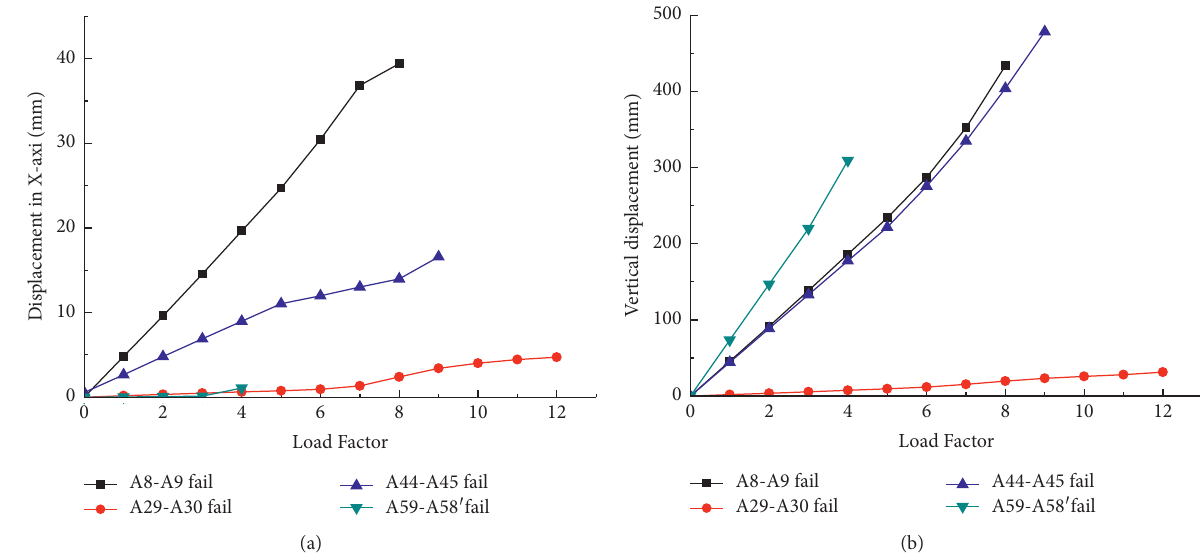
Figure 17: Displacement of the girder in the chord loss scenarios: (a) axial displacement-load response obtained from the finite element model; (b) vertical displacement-load response obtained from the finite element